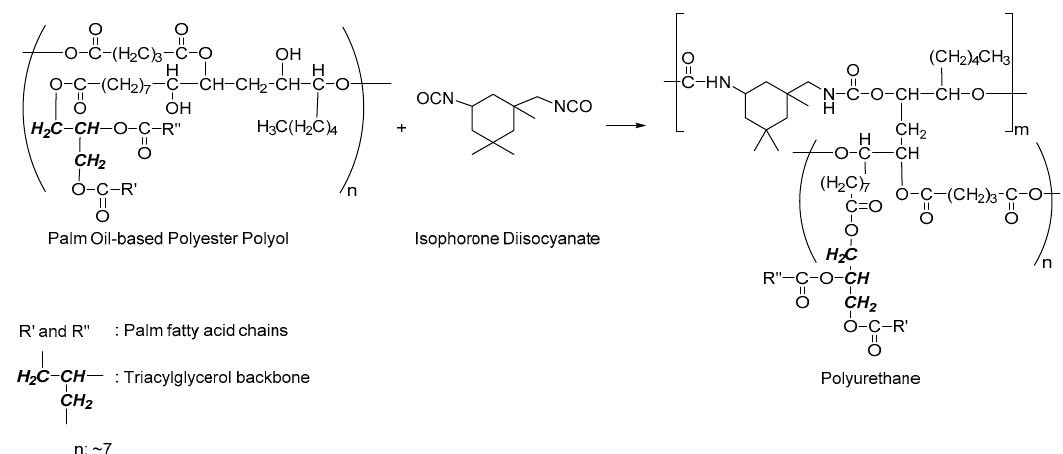
Figure 1. Reaction scheme of palm oil-based polyester polyol reacted with IPDI in producing polyurethane.